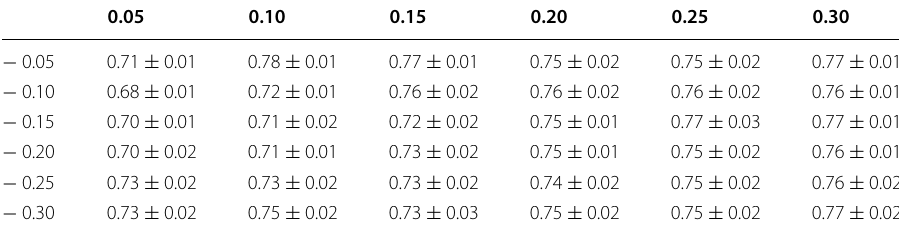
Table 7 Estimated Hurst exponents of the simulated volatilities for different price limit combinations